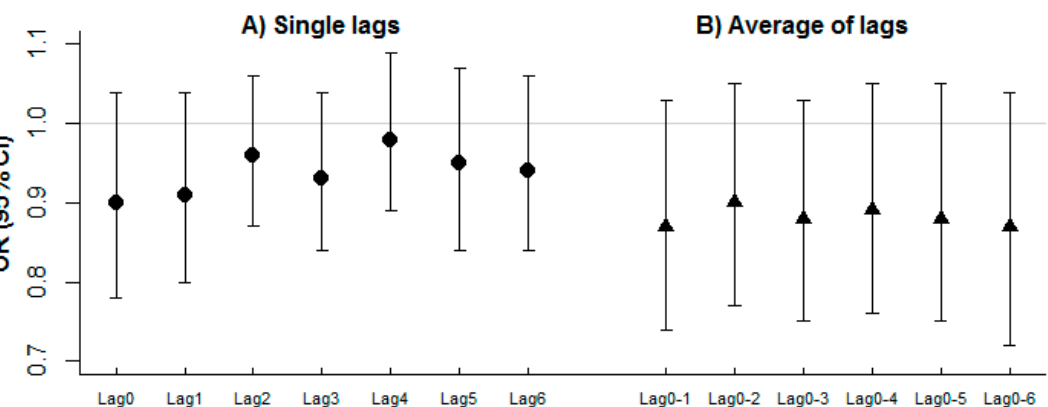
Figure 5. OR (95% CI) for the association of daily RSV admission and average NO concentrations without controlling for relative humidity. ( A ) Single lags; ( B ) Average of lags.